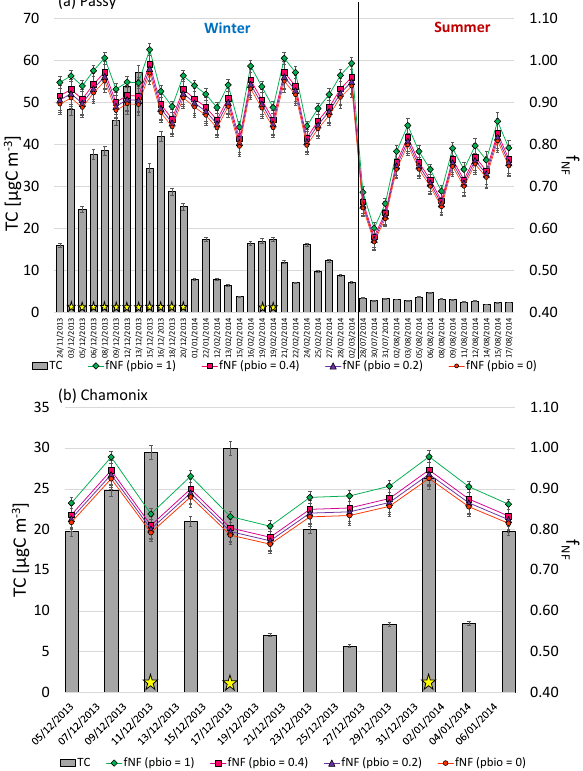
Figure 6. Results for (a) Passy and (b) Chamonix. Grey bars repre- sent carbon concentration. Days with a PM 10 concentration higher than 50µgm − 3 are marked with a yellow star. Green diamonds stand for the only biogenic f NFref , pink squares are for f NFref with a 40% biogenic fraction, purple triangles denote f NFref with a 20% biogenic fraction, and red dots stand for f NFref with a 0% biogenic fraction. In all cases, the non-fossil fraction remains at very high levels during the winter season, validating the importance of the non-fossil source. A maximum variation of 6% is observed in the different f NF